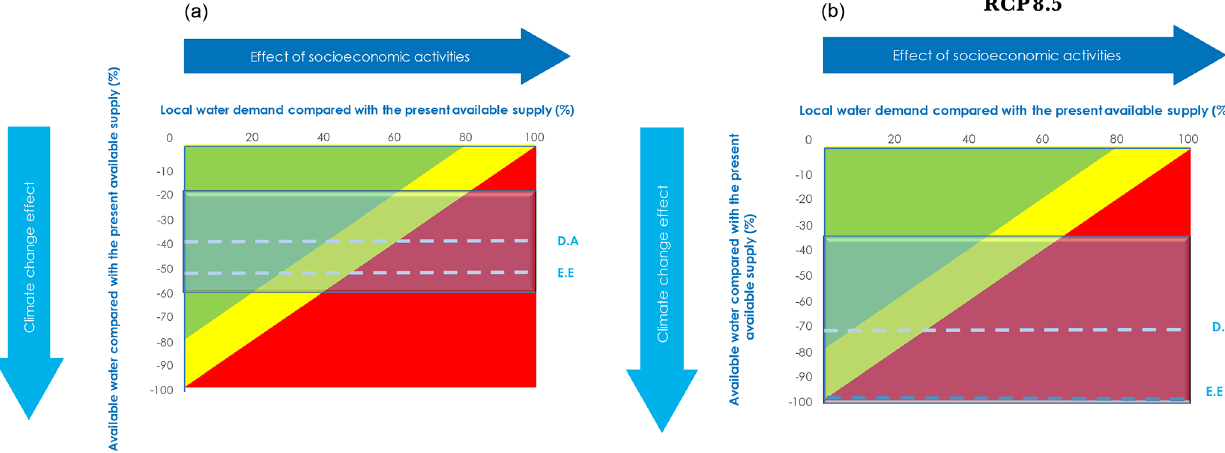
Figure 11. Mapping of the vulnerability function of local water demand and supply following RCP4.5 (a) and RCP8.5 (b) . The green region is where the project is feasible, the yellow region is where it should be rescaled and the red region is where it is infeasible.The shadowed regions represent the uncertainty levels. “D. A”refers to data analysis, and “E. E” refers to empirical